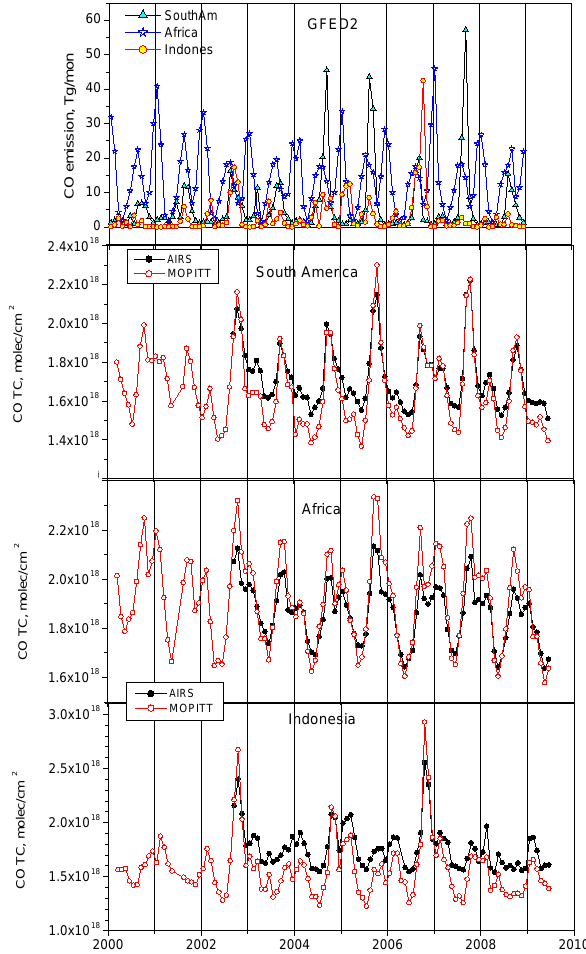
Fig. 12. Corrected monthly mean CO TC from the two satellite sounders averaged over three tropical regions subjected to biomass burning and in comparison with GFED2 emissions.